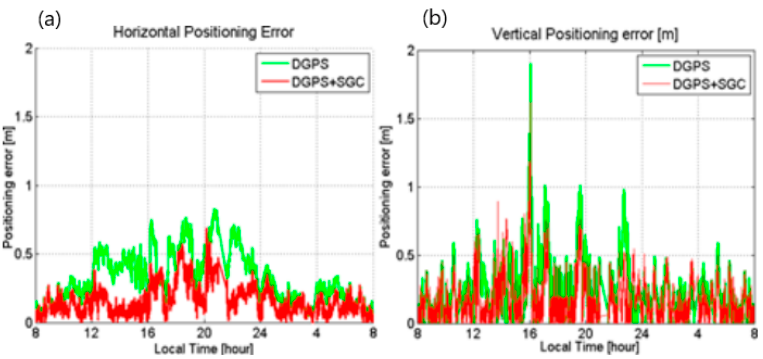
Figure 8. Horizontal ( a ) and vertical ( b ) positioning DGNSS results (HKKT–HKKY) on 4 March 2001.